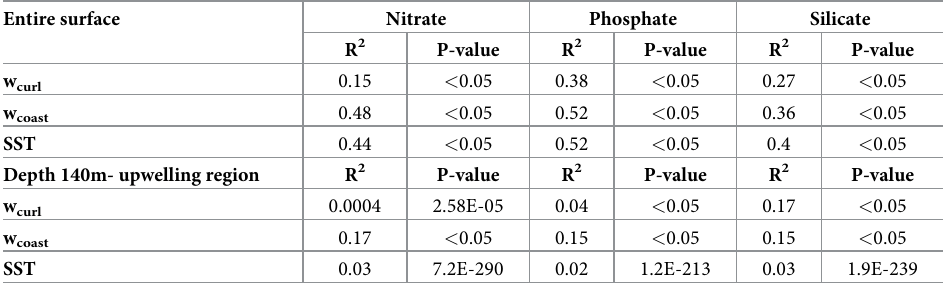
Table 5. Coefficient of determination (R 2 ) and its corresponding-significance test p-values, between all pairs of variables: Nutrients (nitrate, phosphate, silicate), vertical velocity of coastal upwelling (w curl ), vertical velocity of curl-driven upwelling (w coast ), sea surface temperature (SST) for: 1) the entire region of the Sea of Oman, 2) at the upwelling region, and 3) at depth of 140m of the upwelling region. Entire surface Nitrate Phosphate Silicate